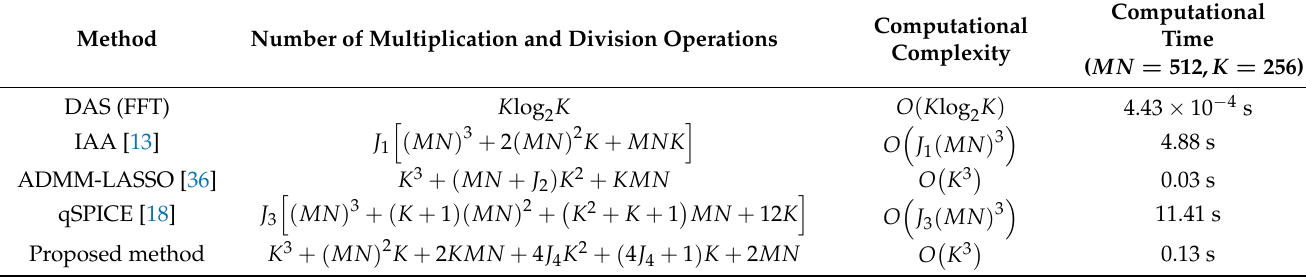
Table 1. Complexity